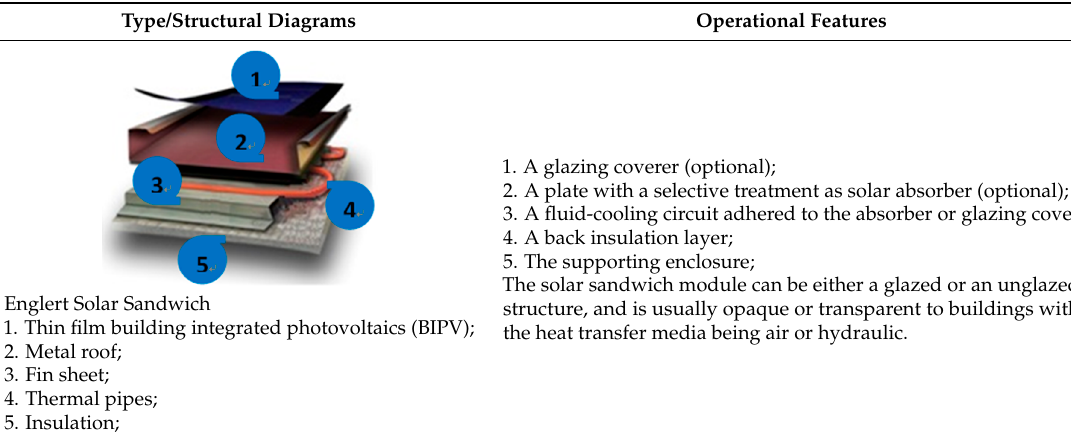
Table 2. Solar sandwich module and phase change core board structure.